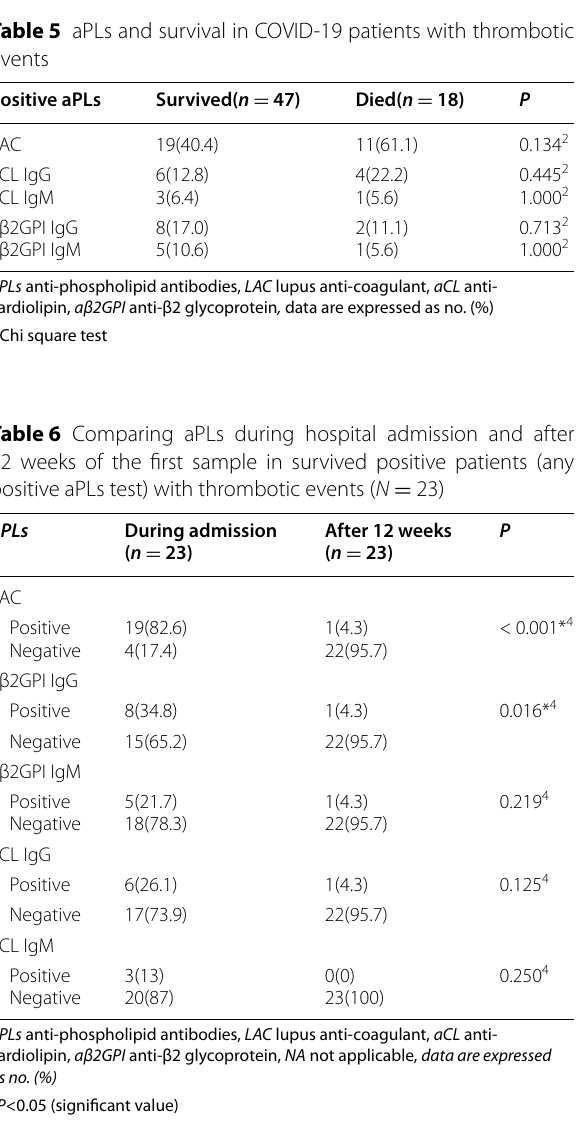
aPLs anti-phospholipid antibodies, LAC lupus anti-coagulant, aCL anti-cardiolipin, aβ2GPI anti-β2 glycoprotein, MI myocardial infarction, RAT renal artery thrombosis, data are expressed as no. (%)